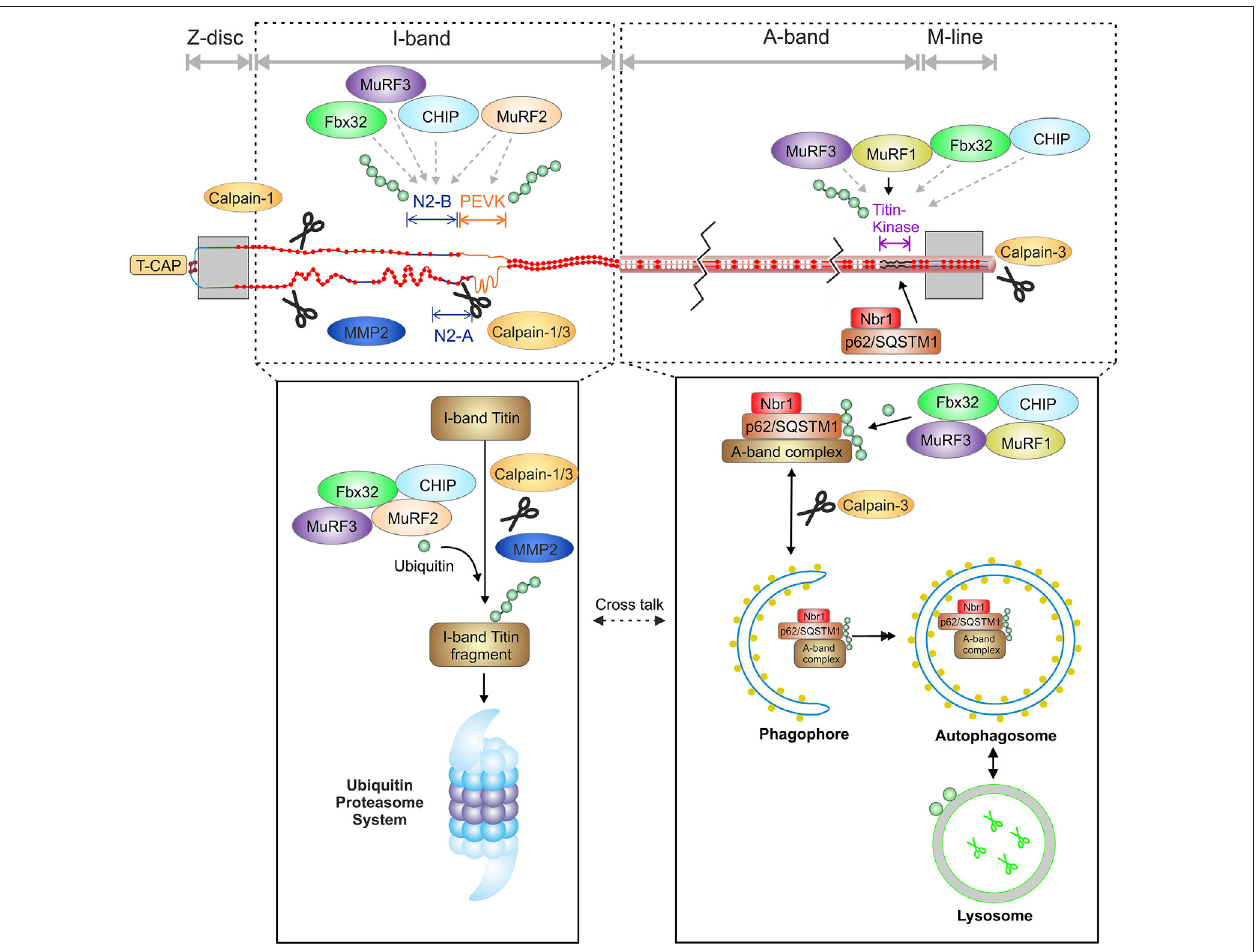
FIGURE2| Schematicoverview oftheinteraction ofthetitin fi lament withcomponentsoftheprotein quality controland suggesteddomain speci fi cdegradation of titin by the proteasome and autophagy. MMP2, matrix metalloproteinase-2; T-CAP, titin cap/telethonin; N2-B, cardiac speci fi c domain; PEVK, Prolin, glutamate, valine and lysine rich